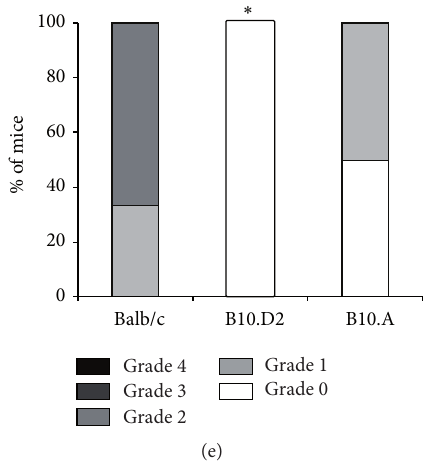
Figure 2: mHAg are a barrier for induction of donor specific tolerance through BMT plus CB. (a) BL6 (H 2 b ) recipients of bone marrow of fully MHC mismatched Balb/c (H 2 d , mHAg mismatched), B10.D2 (H 2 d ), or B10.A (H 2 a , both mHAg matched) mice were tested for donor specific tolerance through transplantation of donor type and 3rd party skin 7 or 14 weeks after BMT. Treatment with 3 Gy TBI (d − 1 ): transplantation of 2 × 10 7 BMC together with CB (1mg anti-CD154mAb, d0; 0.5mg CTLA4Ig, d2) leads to long lasting ( > 130 days) donor skin graft acceptance in long-term chimeras, which had received BMC from MHC and mHAg mismatched Balb/c (H 2 d ) donors in 10 of 13 mice. Significantly better graft survival was observed in long-term chimeric recipients of MHC mismatched but mHAg identical bone marrow (28/29, B10.D2 and B10.A, ∗ 𝑝 < 0.05 ; pooled data from 2 independent experiments). Skin graft survival was calculated according to the Kaplan-Meier product limit method and compared by using the log-rank test. ∗ 𝑝 < 0.05 versus Balb/c donors. (b) Chimerism levels of long-term chimeras, which received Balb/c BMC were not significantly different in tolerant mice (circles I ) compared to mice, which rejected (squares ◼ ) donor skin grafts. 𝑝 = n.s. for all time points. (c) Macroscopical aspects of Balb/c (H 2 d , mHAg mismatched) donor skin grafts changed during the observation period with grafts showing shrinking, thickening, and loss of surface structure. In comparison, donor grafts of B10.D2 (H 2 d ) and B10.A (H 2 a , both mHAg matched) mice stayed macroscopically unchanged from 7 days after skin grafting (when protectingbandage was removed) untilthe end of observationperiod.(d) Representative histology of donor skin grafts of Balb/c(left), B10.D2 (middle), and B10.A (right) 44 weeks after skin grafting. HE staining, magnification 160x, and Giemsa staining 160x (not shown) analyzed. (e) Classification of donor skin grafts 44 weeks after skin grafting according to The Banff 2007 Working Classification of Skin-Containing Composite Tissue Allograft Pathology [19] by a blinded expert pathologist. ∗ 𝑝 < 0.05 versus Balb/c. Most of Balb/c donor skin grafts showed histologically moderate (grade 2, 2/3) signs of inflammation whereas all B10.D2 donor skin grafts were free of inflammatory infiltrates (grade 0, 𝑛 = 4 , ∗ 𝑝 < 0.05 ). B10.A partially showed no (grade 0, 2/4) or mild signs of inflammation (grade 1, 2/4, 𝑝 = n.s. versus